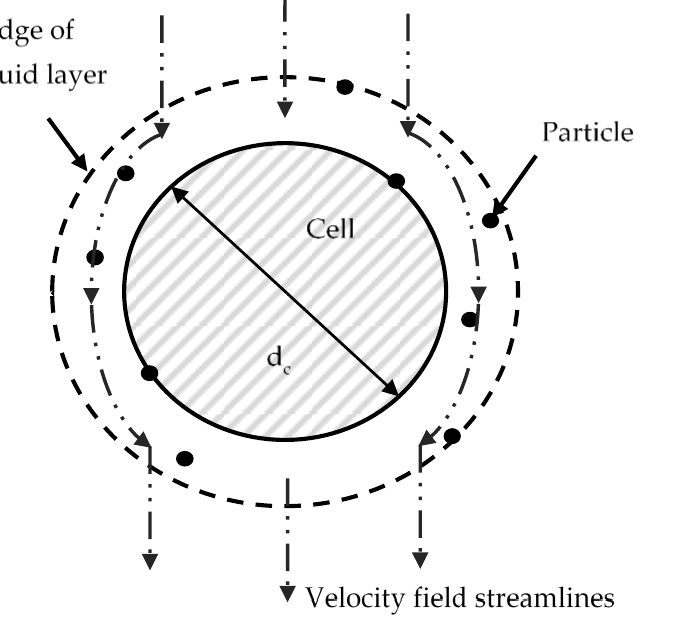
Figure 1. Particle trajectory tracking model geometry, the Happel cell-in-sphere model.